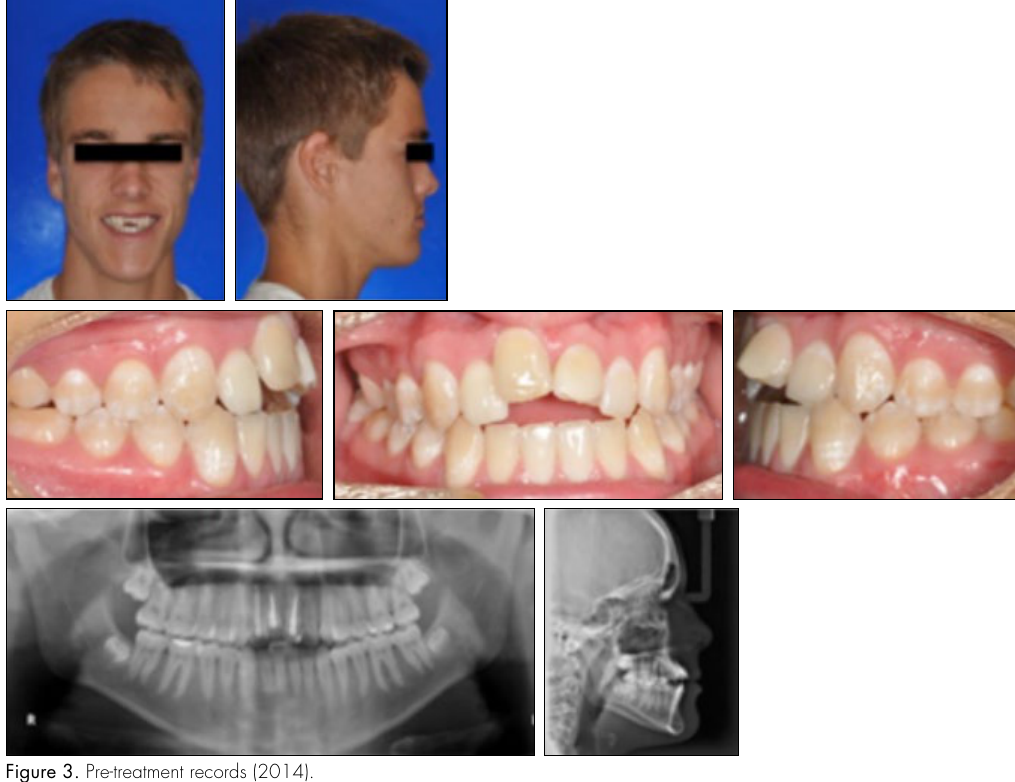
Figure 3. Pre-treatment records (2014).